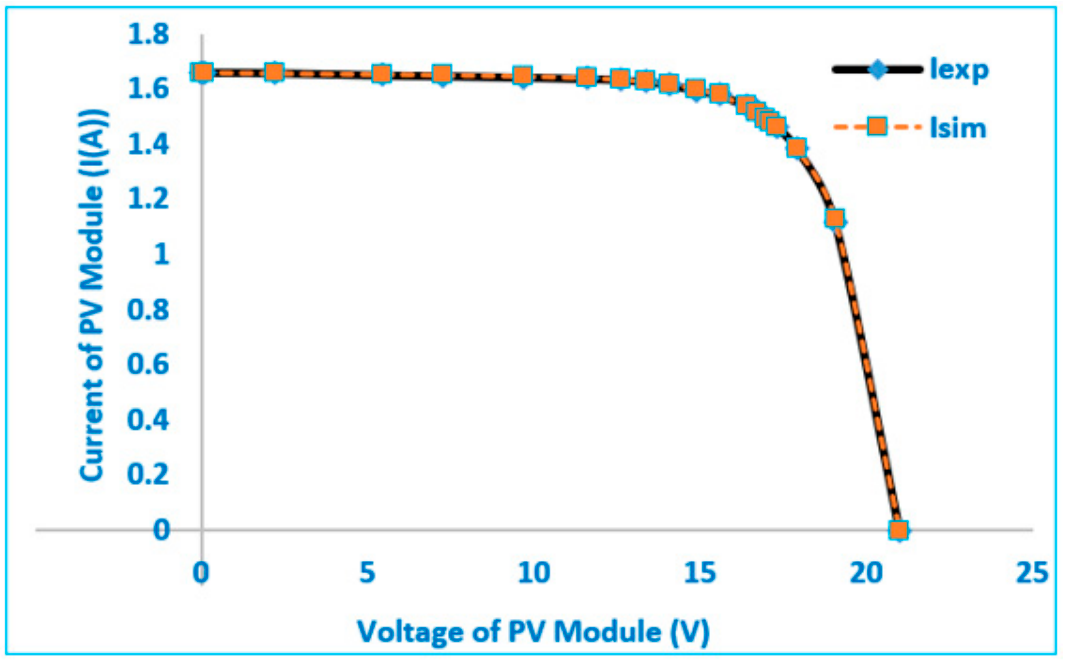
Figure 6. I–V characteristics of the proposed HPO technique for the single-diode STM6_40/36 PV module.